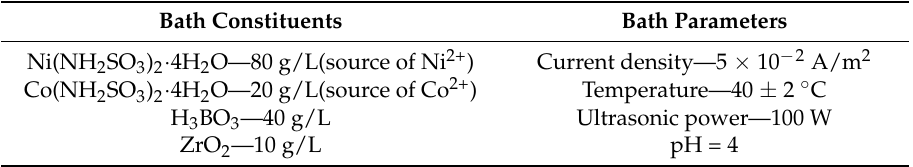
Table 1. The composition of electroplating solution and electrodeposition